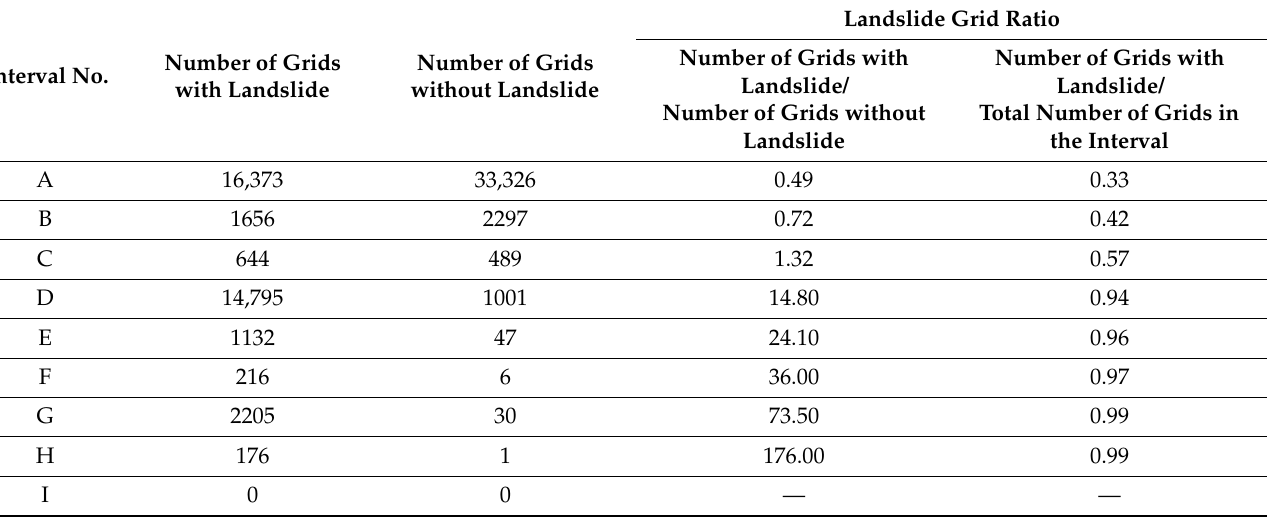
Table 6. The I HERI , I DLD , and number of grids with and without landslides and the ratio of the landslide grids in each interval corresponding to the occurrence of landslides.